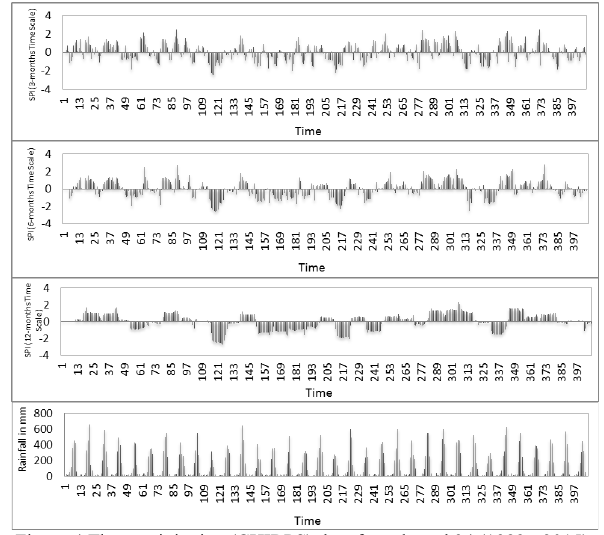
Figure 4 The precipitation (CHIRPS) data for selected 34 (1982 - 2015) within SPI at 3-, 6- and 12-month time